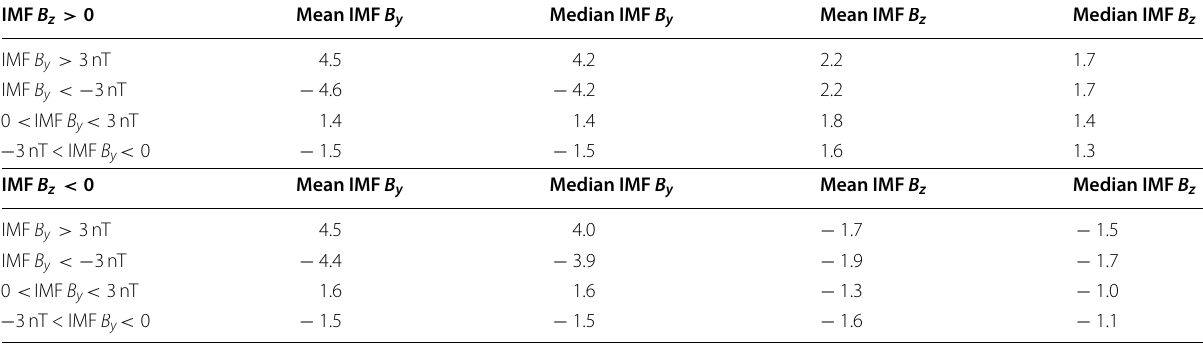
Table 1 Mean and median of IMF B y and IMF B z tagged to the neutral sheet crossings in each of the IMF categories (in